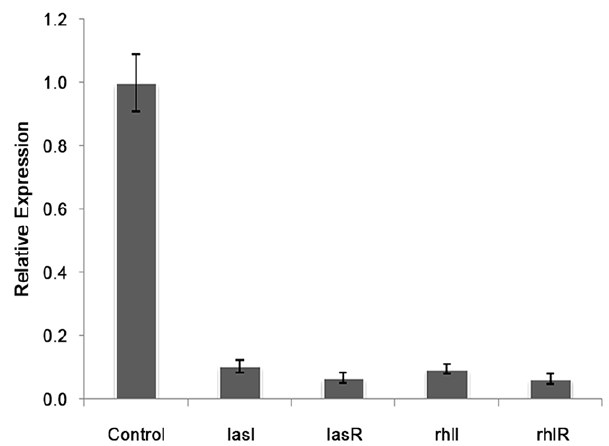
Figure 6. Relative expression of lasIR and rhlIR genes of P. aeruginosa PAO1 in the presence of 0.5 mg/ml F7 as deter- mined by qRT PCR.